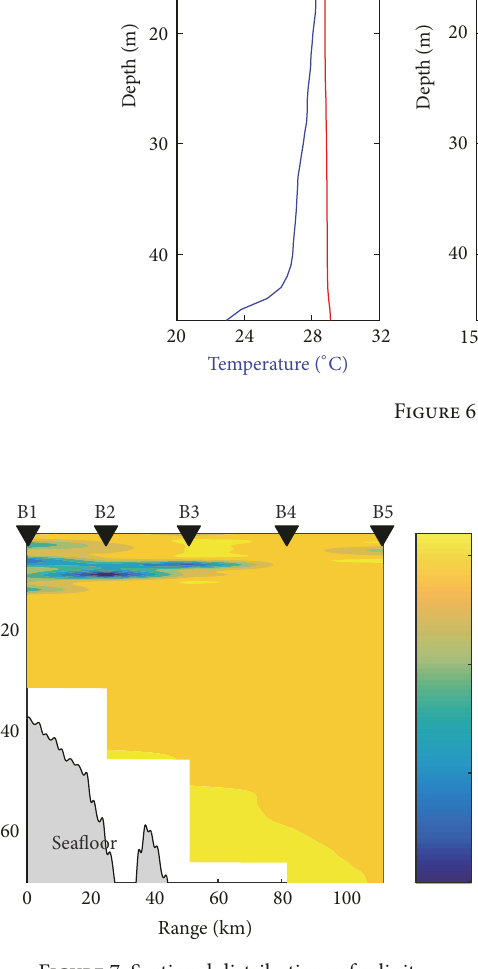
Figure 7: Sectional distributions of salinity.